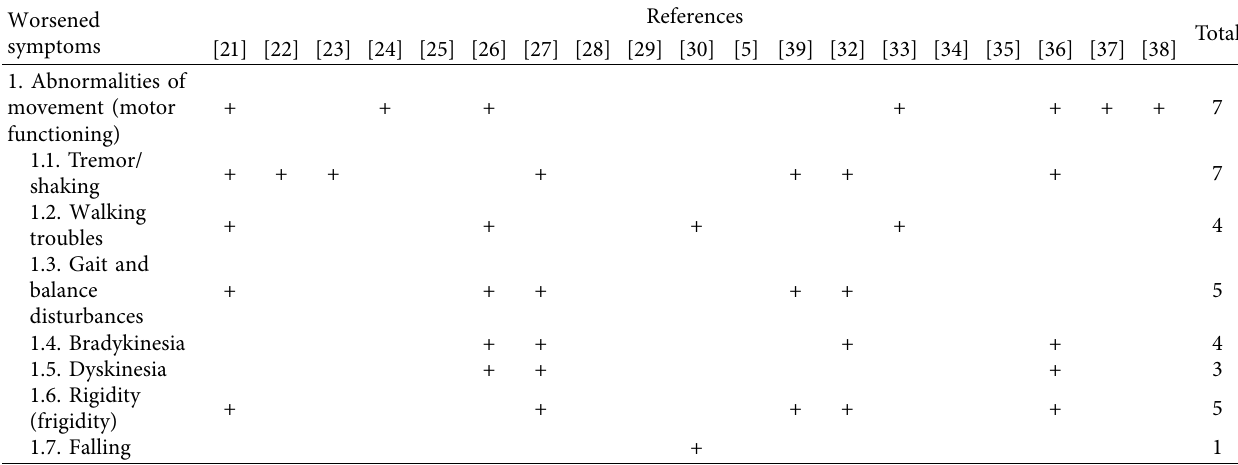
Table 6: Worsened symptoms in Parkinson’s patients who have been afected in the